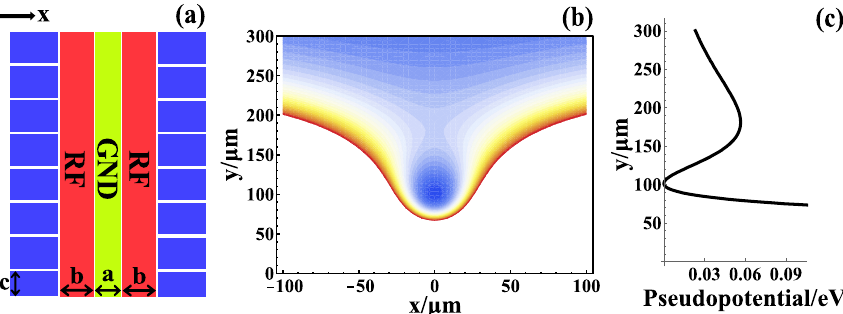
Figure 1. Symmetrical five-wire SEIT: ( a ) The geometric dimensions of the electrode. The widths of the ground electrode, RF electrode and segmented DC control electrode are a = 180 μm , b = 145 μm , and c = 150 μm , respectively; ( b ) The radial distribution of pseudopotential. The pseudopotential decreases from red to blue; ( c ) Pseudopotential distribution in the y direction ( x = z = 0). The trap depth is about 0.06 eV . The trapping height and escaping point is about 100 μm and 175 μm , respectively.